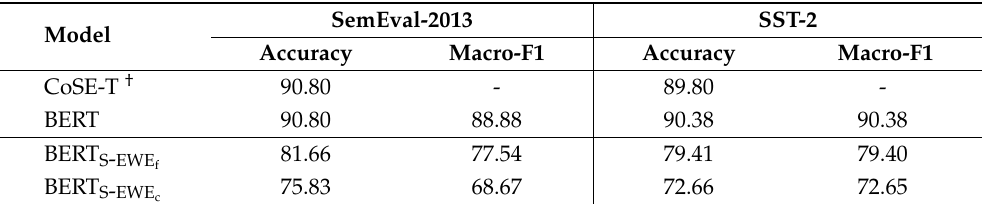
Table 8. Theaccuracies and macro-F1 scores of BERT (with and without S-EWE) and CoSE-T on SemEval-2013 and SST-2 datasets (%). † represents that the results are from